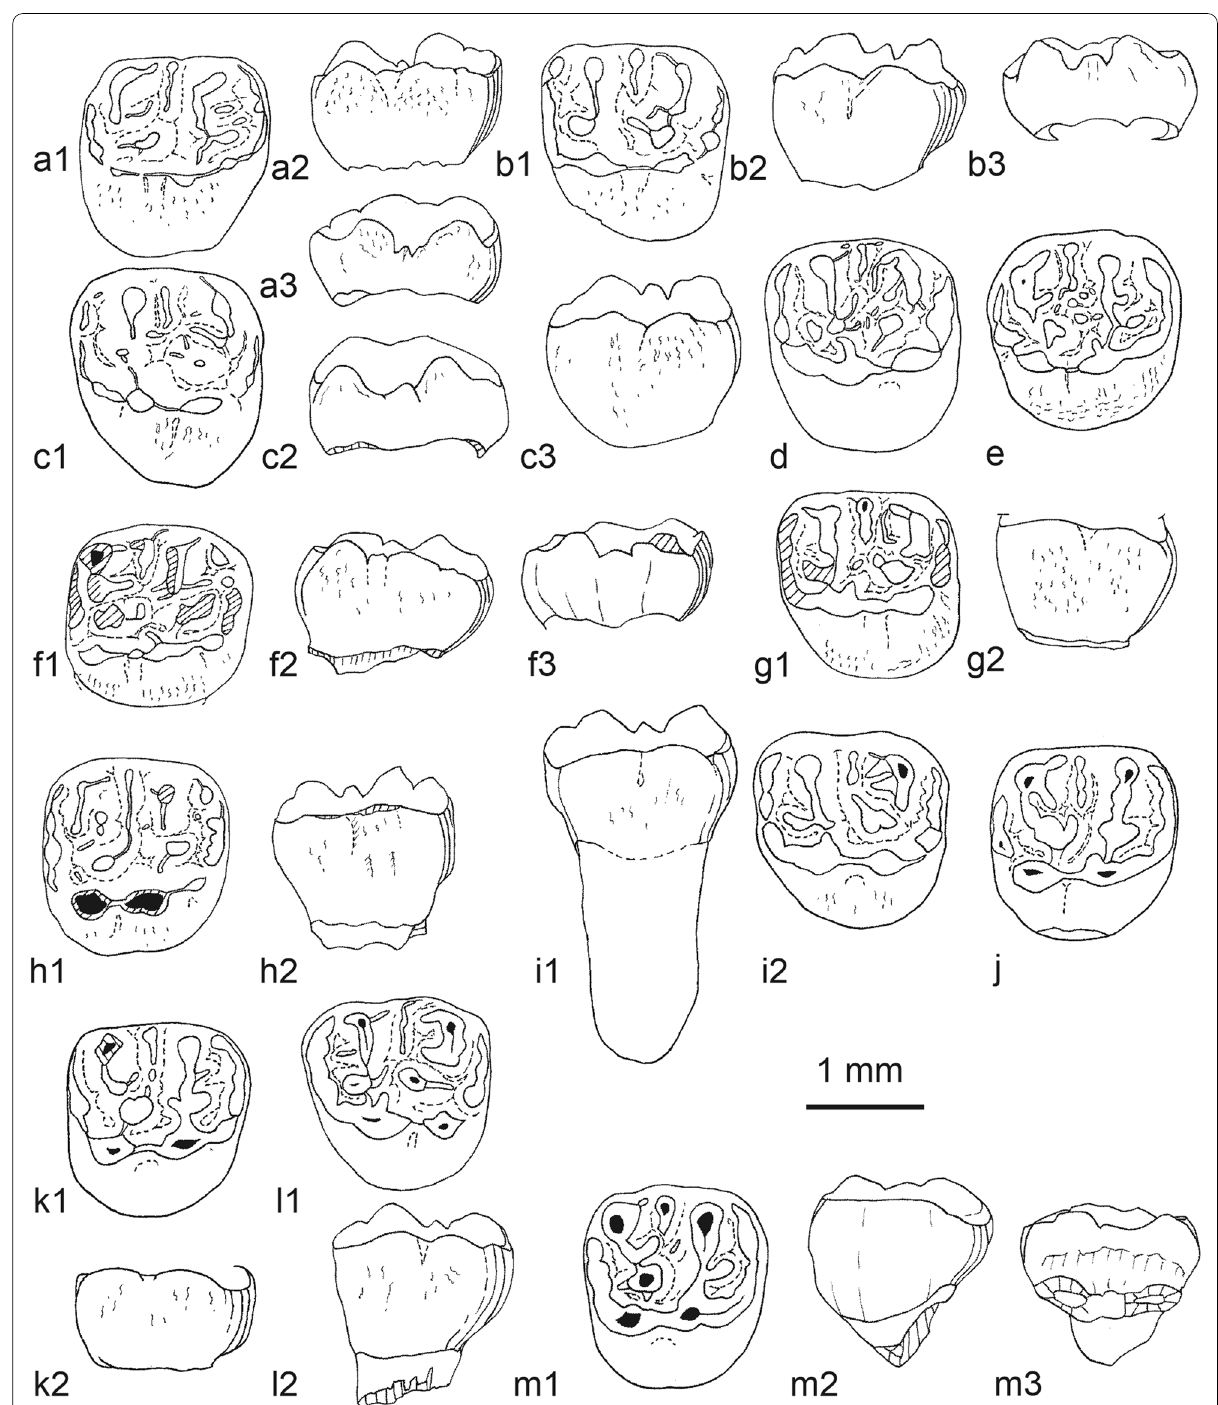
Fig. 30 Upper M1 of ? Protadelomys alsaticus Hartenberger, 1969 from Bouxwiller (Bas‑Rhin). a CSBX32, right M1; a1, occlusal view; a2, lingual aspect; a3, buccal aspect. b CSBX67, left M1; b1, occlusal view; b2, lingual aspect; b3, buccal aspect. c: CH41, right M1; c1, occlusal view, c2, buccal aspect; c3, lingual aspect. d BUX67‑24, left M1, occlusal view. e BUX67‑66, right M1, occlusal view. f BUX67‑61, right M1; f1, occlusal view; f2, lingual aspect; f3, buccal aspect. g BUX67‑68, left M1; g1, occlusal view; g2, lingual aspect; g3: buccal aspect. h BUX67‑54, right M1; h1, occlusal view; h2, lingual aspect. i BUX67‑47, left M1; i1, lingual aspect; i2, occlusal view; j: BUX67‑53, right M1, weakly worn, occlusal view. k : BUX67‑43, right M1; k1, occlusal view; k2, lingual aspect. l : CH49, left M1; l1, occlusal view; l2, lingual aspect. m : BUX67‑46, right M1; m1, occlusal view; m2, lingual aspect; m3: buccal aspect. Scale bar: 1